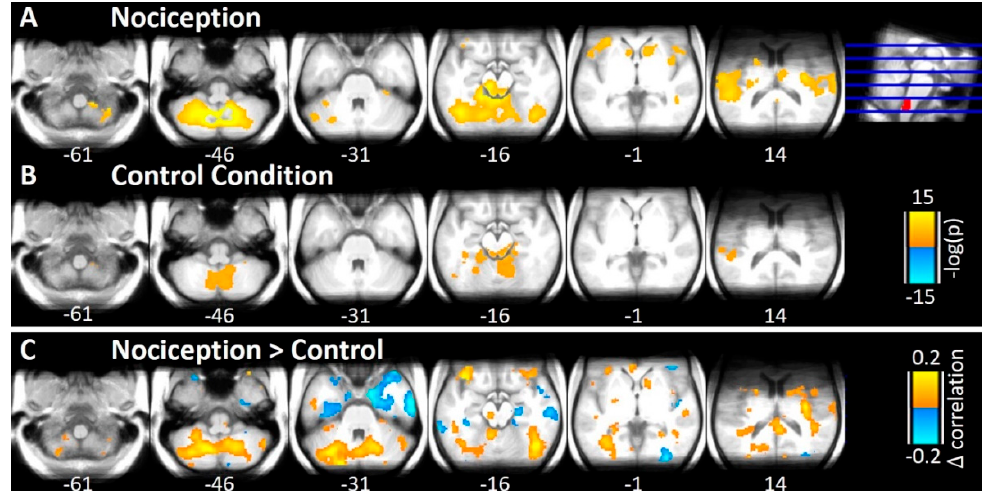
Figure 3. Results of the Similarity analysis. ( A ) Log-transformed significance of correlations (Spearman) in trial-to-trial variability between the left STN (marked in red at the top right corner) and cerebellum, brainstem, and midbrain during nociception at a statistical threshold of p < 0.0001 (FDR-adjusted) and a minimum cluster extent of 5 voxel. ( B ) The same results for the control condition. ( C ) Difference of the correlation coefficients between the two conditions (nociception > control). Positive findings signify higher correlation during nociception than during air puffs (marked in orange) whereas negative correlation is depicted in blue.